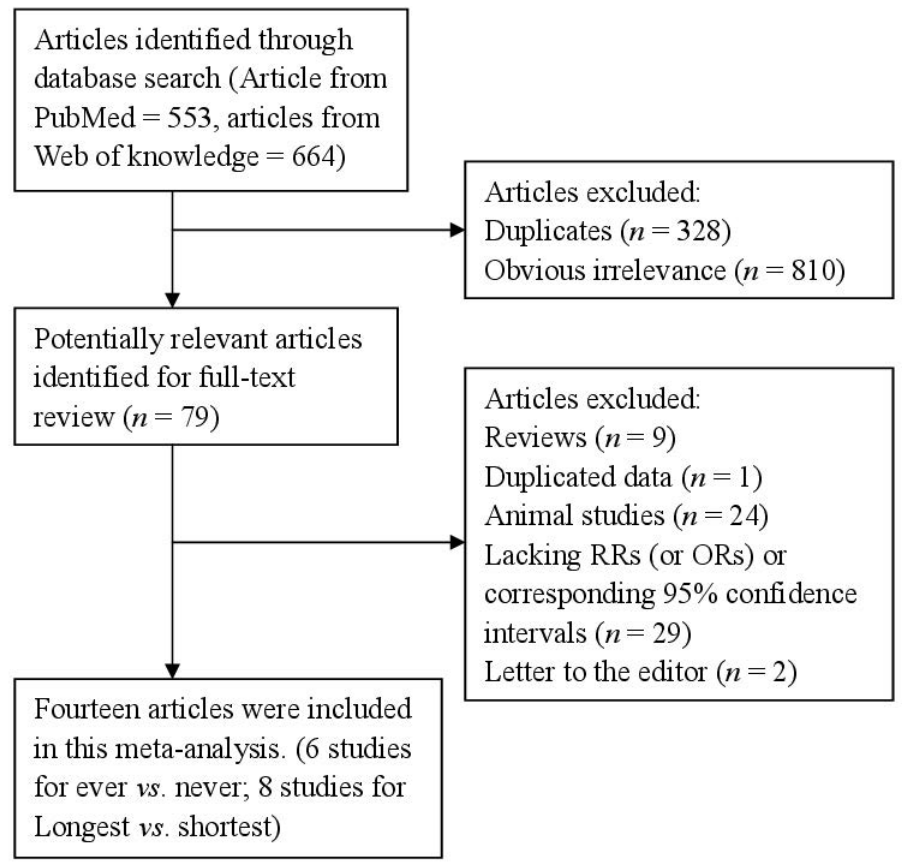
Figure 1. The flow diagram of screened, excluded, and analyzed publications.